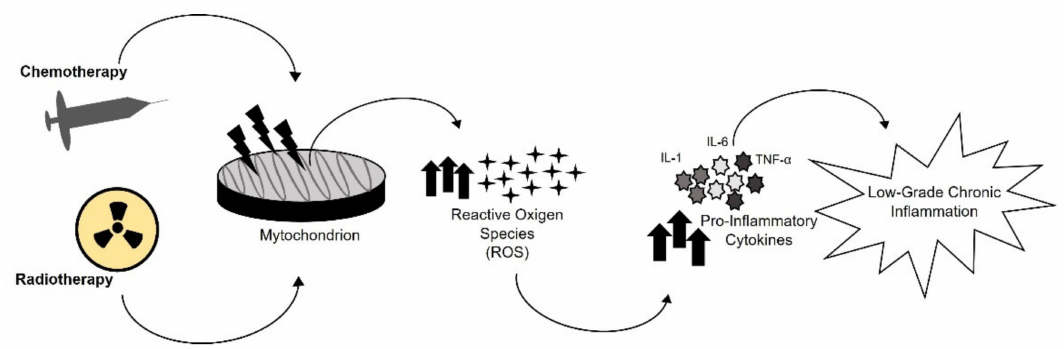
Figure 3. Oxidative stress. Chemotherapy and radiotherapy induced mitochondrial DNA damage, causing an increased production of Reactive Oxygen Species (ROS). ROS led to the activation of pro-inflammatory pathways, which induce inflamm-aging